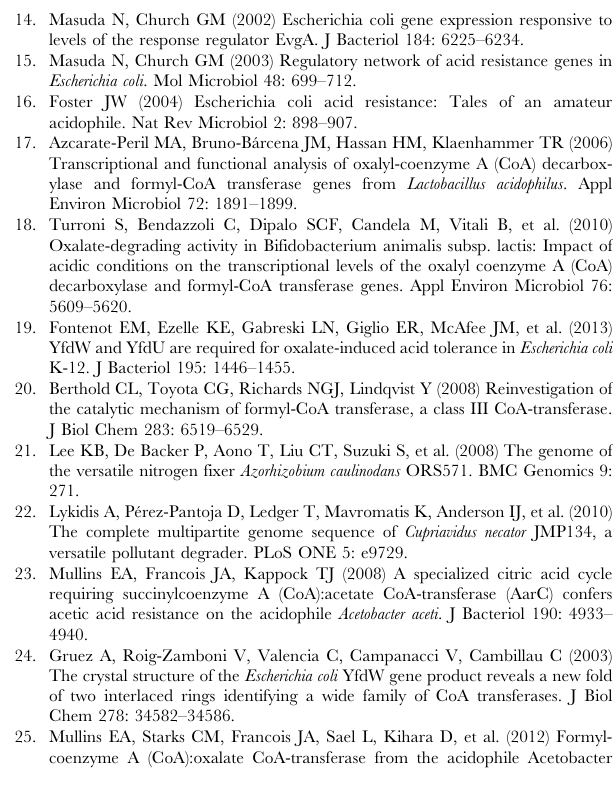
Figure S2 Acyl-CoA hydrolysis half-lives. Determination of Figure S6 Structure-based sequence alignment of eight class III CoA-transferase superfamily members. This the half-lives for spontaneous acyl-CoA hydrolysis in quenched alignment corresponds to the structure superposition in Figure 2B. reaction mixtures. Each solid line represents a fit of the data to the ~ ½ A (cid:2) Secondary structure elements, except 3 10 helices, are shown for exp( { kt ) . (A) Acetyl-CoA half-life is 92 h: function ½ A (cid:2) t 0 H6YfdE (PDB entry 4hl6). The active site Asp is indicated by a red triangle. The locations of the ACOCT GNxH loop (PDB entry 4hl6) and FCOCT Gly-rich loop (PDB entries 1p5h, 1pt7, and 3ubm) are underlined in blue. In the YfdE sequence, large domain residues are upper-case and small domain residues are lower-case. The percent identity/similarity for each pair of sequences is given in Table S2. (PDF) Figure S3 Determination of ACOCT kinetic parame- ters. (A/B) YfdE (filled circles and red traces), H6YfdE (open Table S1 Mass spectrometric characterization of YfdE and UctC. circles and blue traces), and YfdEH6 (filled triangles and gray (PDF) traces). (C/D) UctC. Acetyl-CoA saturation curves (panels A and C) were determined at 50 mM oxalate. Oxalate saturation curves Table S2 Pairwise comparison of eight class III CoA- (panels B and D) were determined at 0.75 mM acetyl-CoA. Each transferase superfamily members. solid line is a non-linear least-squares fit to the Michaelis-Menten equation. Kinetic parameters derived from these plots are given in Table S3 Oligodeoxynucleotides used in this study. Figure S4 Stereogram of electron density in the H6YfdE active site. The active site formed by subunits A and B is depicted from the perspective of Figure 6. Asp173 is shown in ball- and-stick rendering. Other protein atoms and waters are shown in stick and sphere rendering, respectively. The s A-weighted 2 mF o { DF c electron density map (blue mesh) is contoured at 1.2 s and carved with a 2.5 A˚ radius. Figure S5 Topology diagram for H6YfdE.